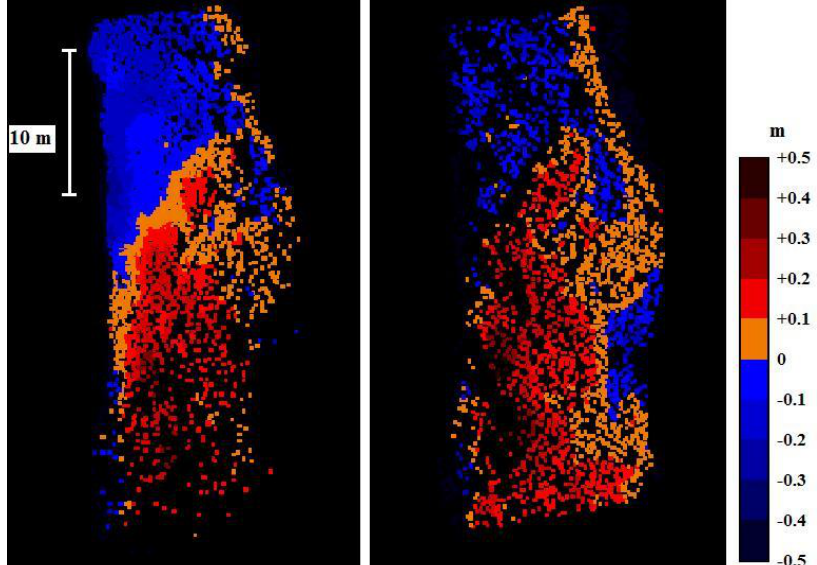
Figure 5. TLS-derived (left) and BoMMS-derived (right) change